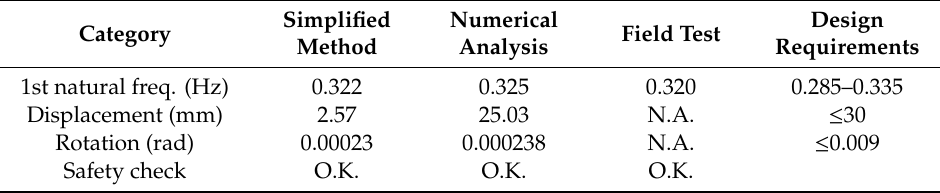
Table 7. Comparison with the results of numerical analysis and field